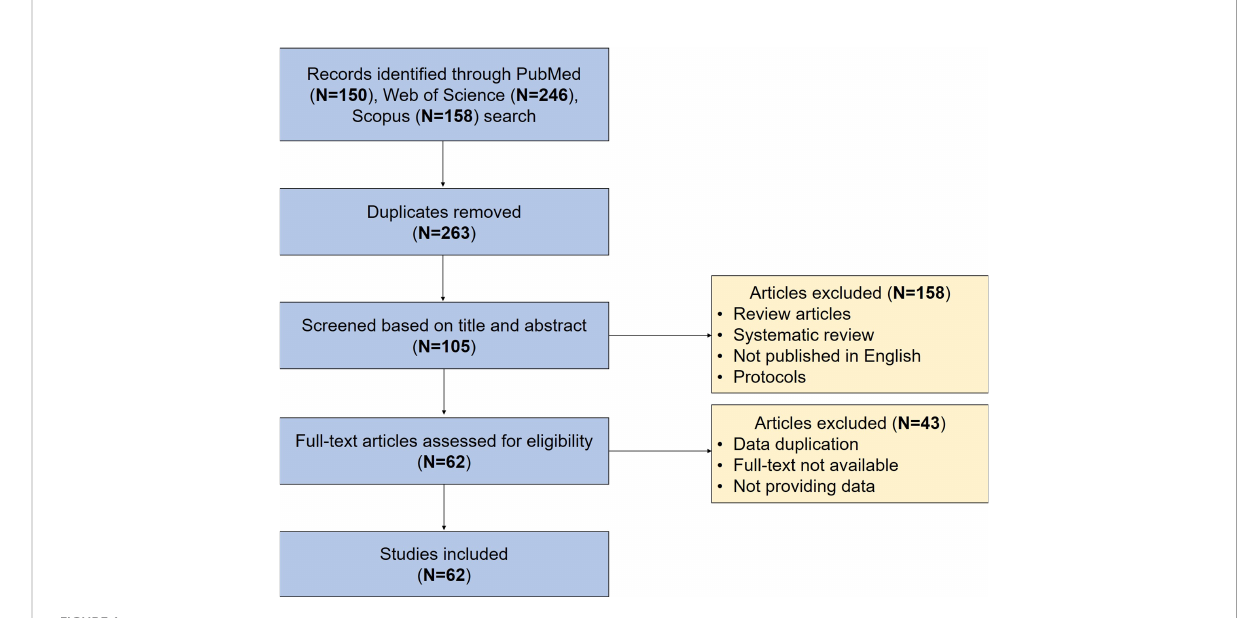
FIGURE 1 Flow chart of the study selection